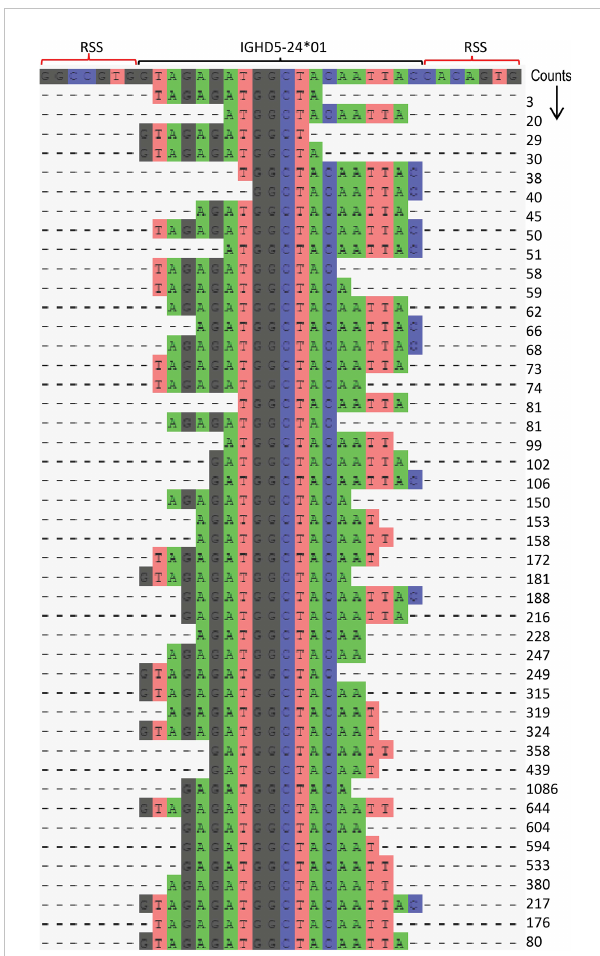
FIGURE 5 Illustration of IGHD LCS analysis procedure using IGHD5-24*01. The corecount LCS procedure identi fi es allele speci fi c substrings from each sequence present in the supplied IGHD allelic database. These LCS substrings are a minimum percentage of the full length IGHD allele, as de fi ned by the user, in this case 60%. The program searches the MiAIRR formatted library table and produces a set of counts for each of these substrings – with each VDJ sequence analyzed providing a maximum count of 1 of this set. An example is shown for allele IGHD5-24*01 in case D19. In this procedure the program utilizes sequences where the remaining segment of IGHD5-24*01 in the VDJ recombinant is central to the D core, but also enables the use of VDJ recombinations that skew towards the 5 ’ or 3 ’ part of the IGHD allele. The position of the V allele and the 5 ’ and 3 ’ RSS heptamers are shown in the top row. A total of 45 unique substrings of IGH5-24*01 are shown to be utilized, each resulting in different counts, the sum of which is the corecount total for this IGHD5-24*01 allelic sequence. This approach enables a series of ‘ cores ’ to be utilized for D gene analysis rather than restricting it to a single central ‘ core ’ of that